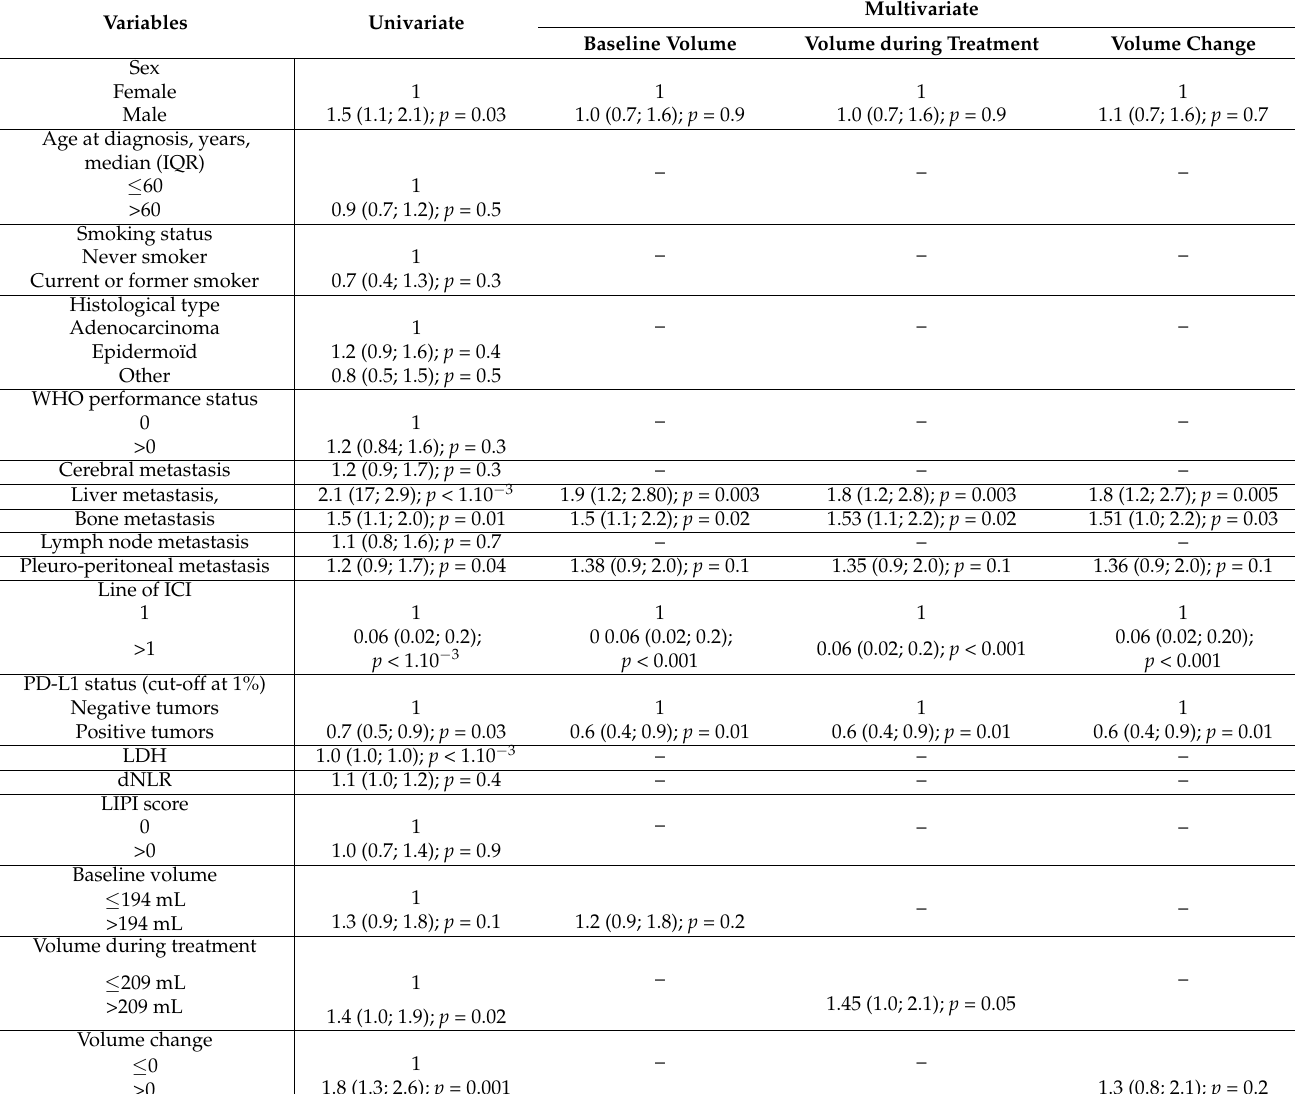
Table 3. Univariate and multivariate Cox models for progression-free survival (PFS). Three multivariates where estimated, each involving either baseline volume, volume during treatment, or volume